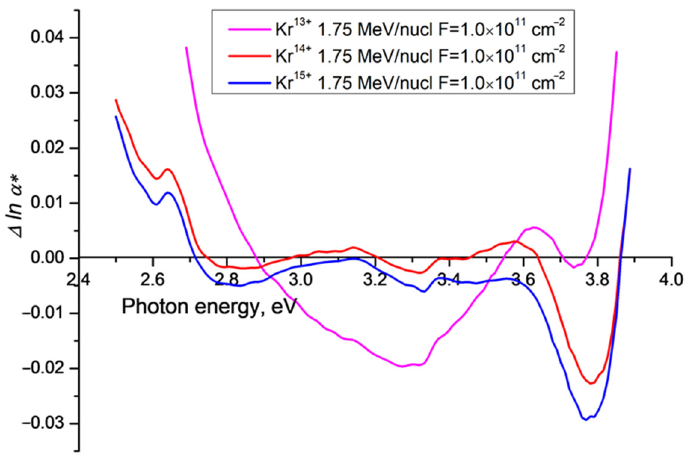
Figure 4. Difference functions Δ ln α *( ν ) for PET films irradiated with Kr ions of charge 13+, 14+ and 15+ with energy 1.2 MeV/a.u. and fluence of 1 × 10 11 cm − 2 at an angle of 42° to the normal.